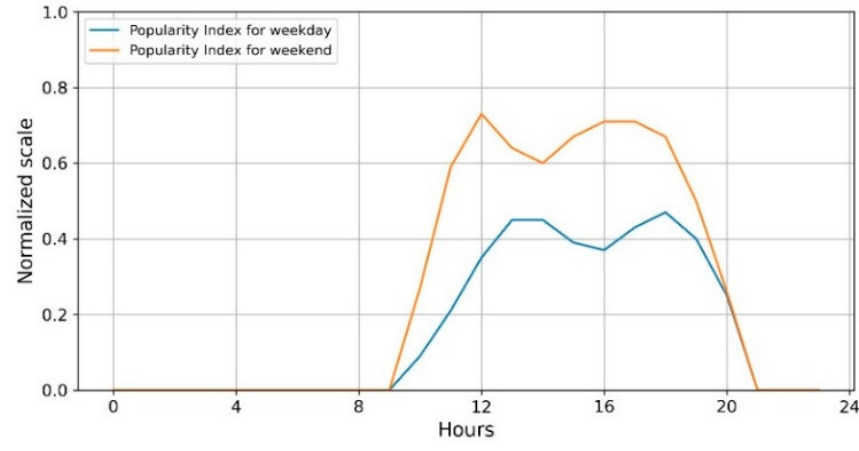
Figure 3. Popularity index comparison over 24 h for both weekdays and weekends. There is clearly a seasonal trend in the monthly and whole-dataset plots of the DSA data, as shown in Figures 4 and 5. This represents a non-stationary data characteristic. Generally, both figures show the same seasonal trend, with the popularity index rising and falling cyclically, affecting the amount of audience attention that can be grabbed. Thus, a dynamic pricing scheme can be applied for DSA to maximize profit.